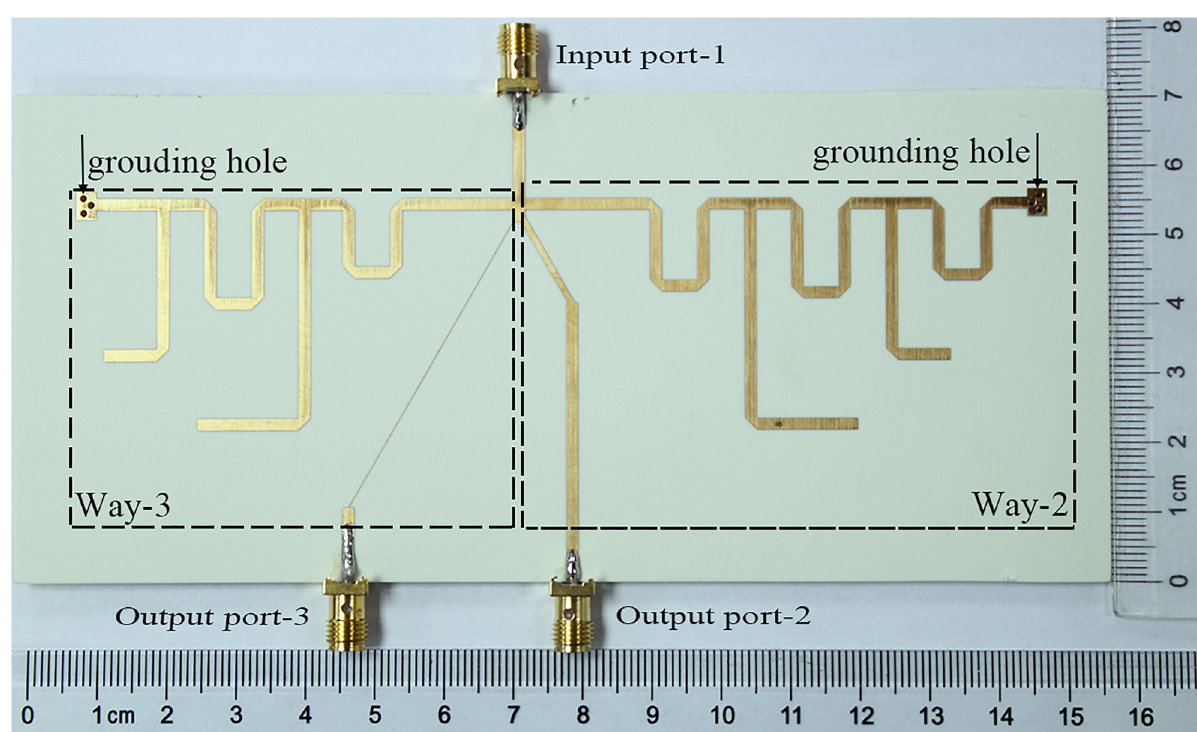
Fig 5. The picture of the TTPD on PCB. The photo of the TTPD is on PCB with the approximate size of 70x150 mm 2 .